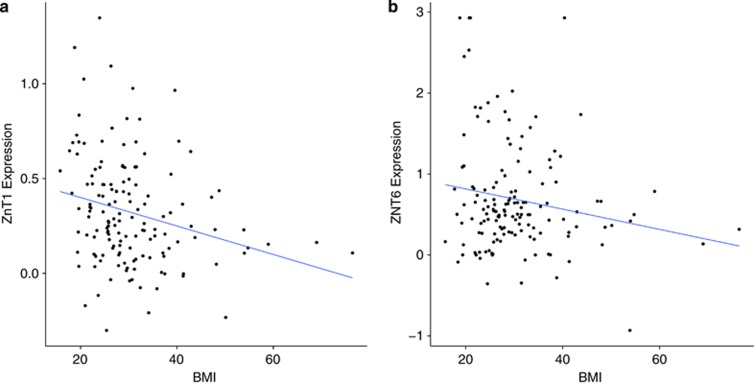
(a and b) On the x axis, BMI (kg/m2) and on the y axis, there are mRNA expressions of ZNT1 (P=0.002) (a), ZNT6 (P=0.03) (b). Expression is expressed as log2 of the ratio of sample signal to the reference signal Each dot represents one individual. Line represents best-fitted line using regression. BMI, body mass index.